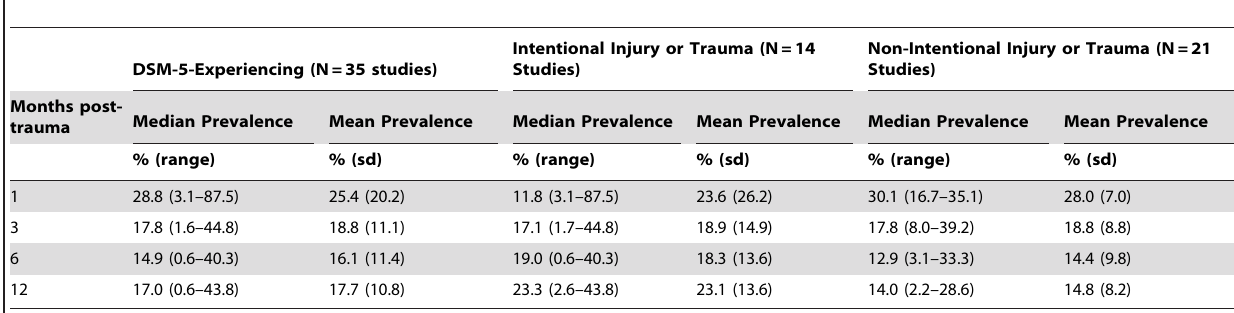
Table 1. Mean and median prevalence of PTSD in exposed populations meeting DSM-5 Direct Experiencing criteria (N =35 studies). 1